Question: Name the type of graph shown.
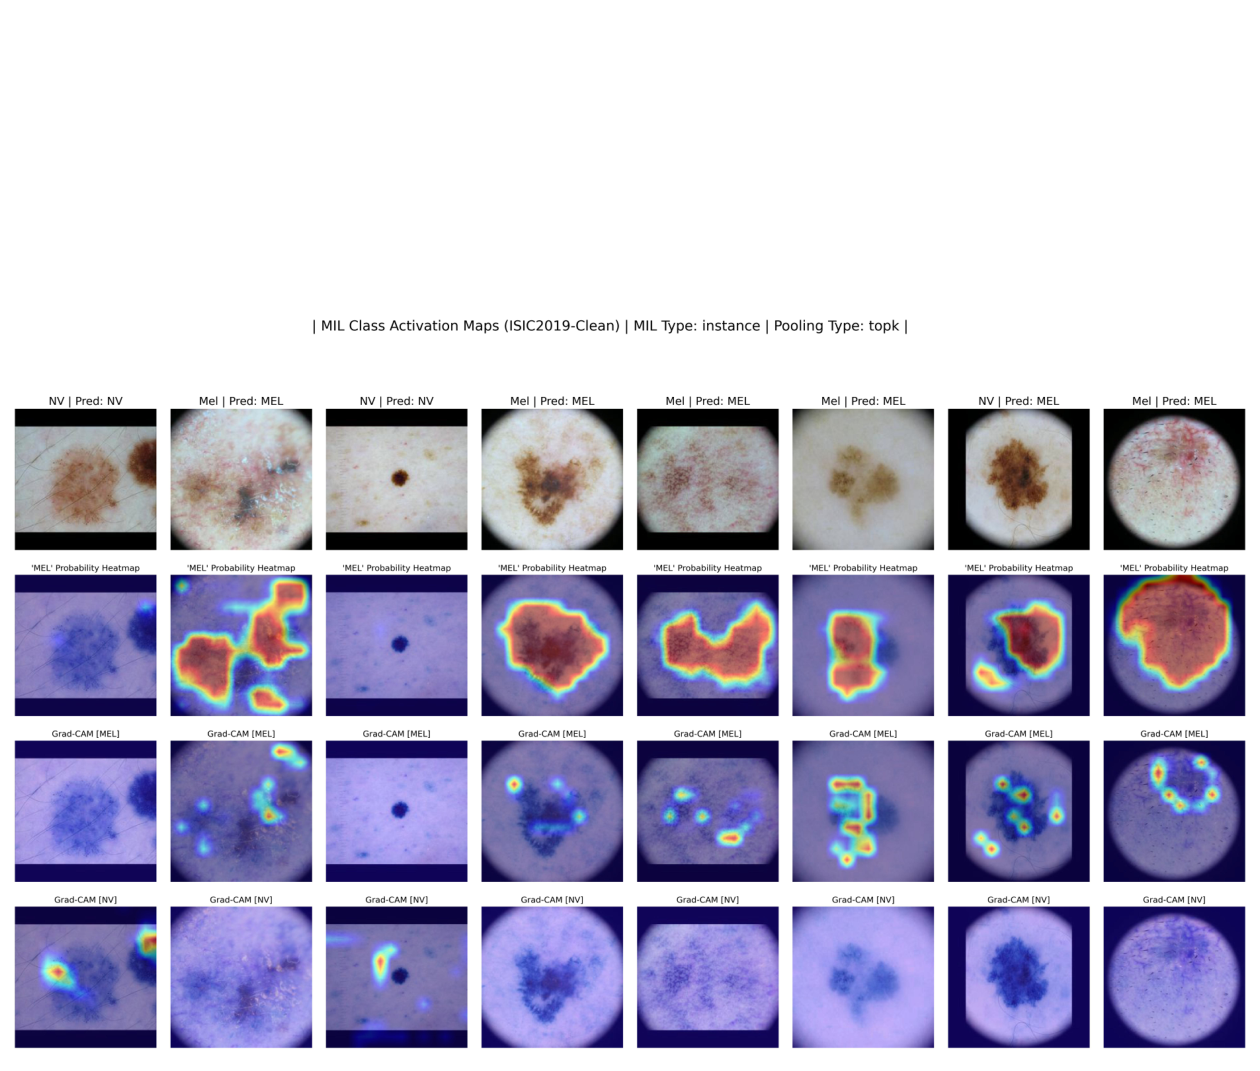
Answer: heatmap